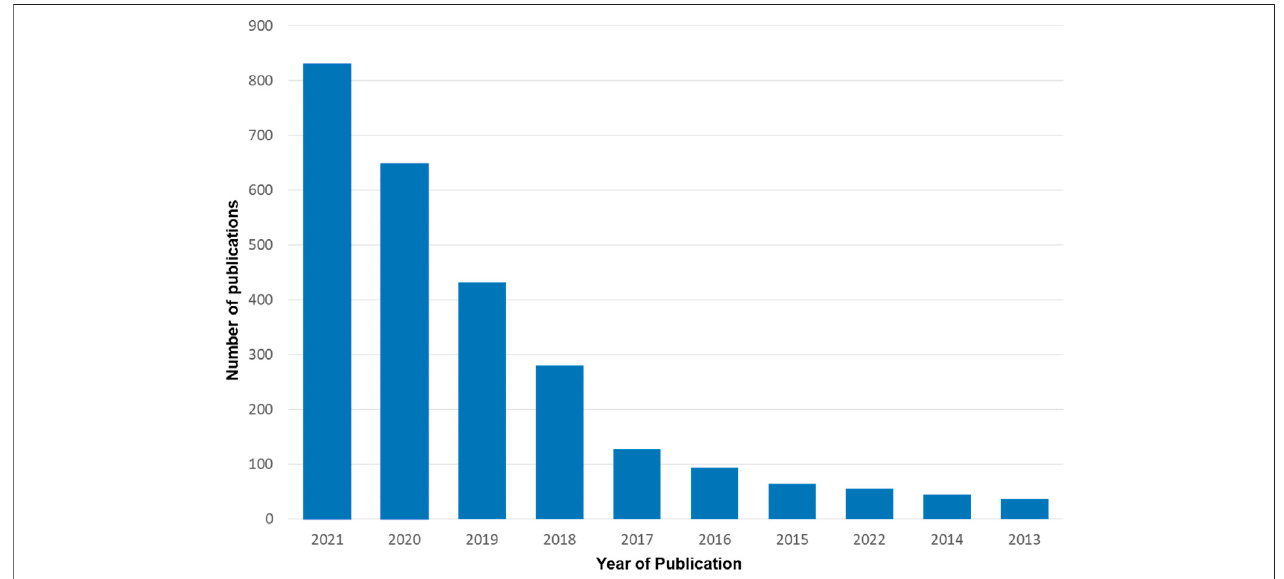
FIGURE 1 | Papers retrieved from the Web of Science using the query “ machine learning and (chemistry or materials discovery) ” on 21 January 2022, per publication year.